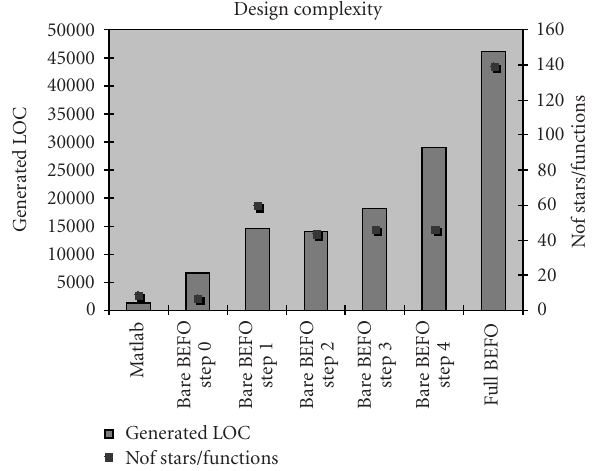
Figure 13: Design complexity of radar benchmark implemented on a Mercury